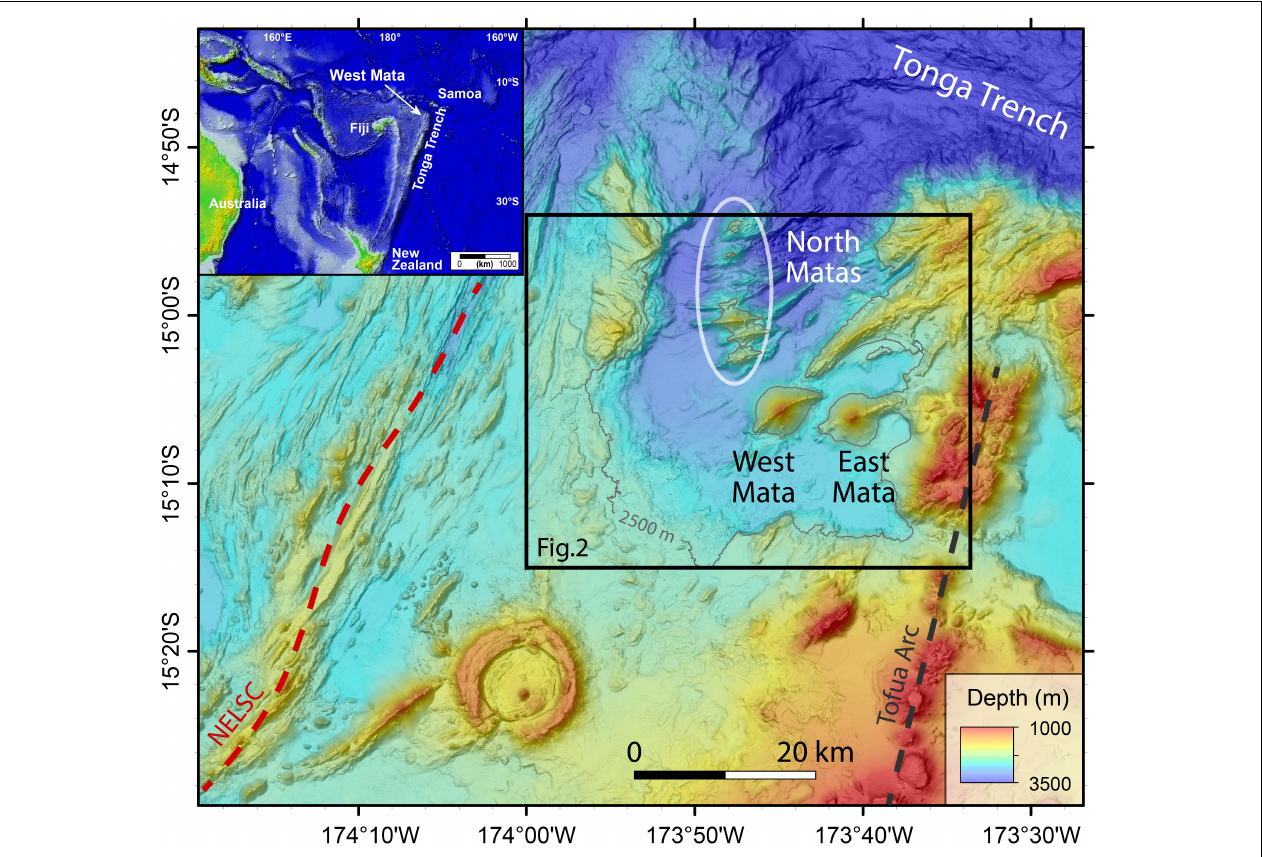
FIGURE 1 | Regional map of the NE Lau basin showing location of West Mata, East Mata and the North Mata volcanoes relative to the Tofua volcanic arc (gray dashed line), NELSC (red dashed line), and Tonga trench (labeled). The black box outlines the area of the map in Figure 2 . Inset shows location of the region in the Southwest Pacific Ocean. See Figure 4 for North Mata volcano names. The 2500 m depth contour (solid gray line, shown only within the black box) generally defines the Mata Depression